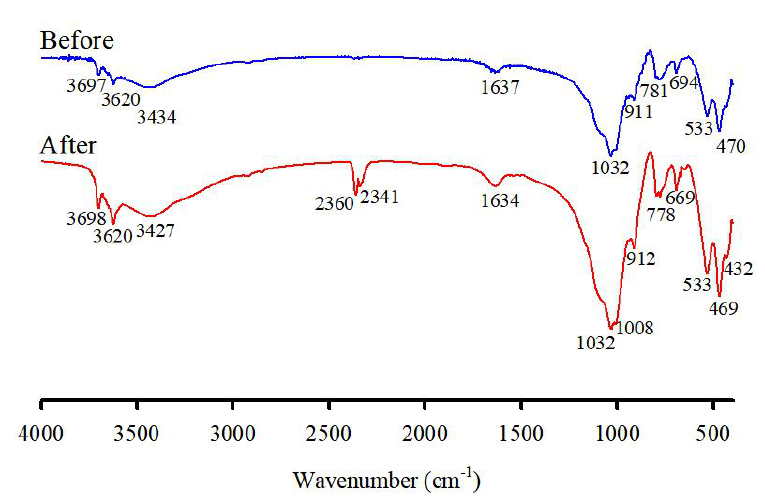
(-COO) [7,8]. The Si-O-Si band is observed at 1032 cm − 1 as a result of the Si-O vibration. quartz.